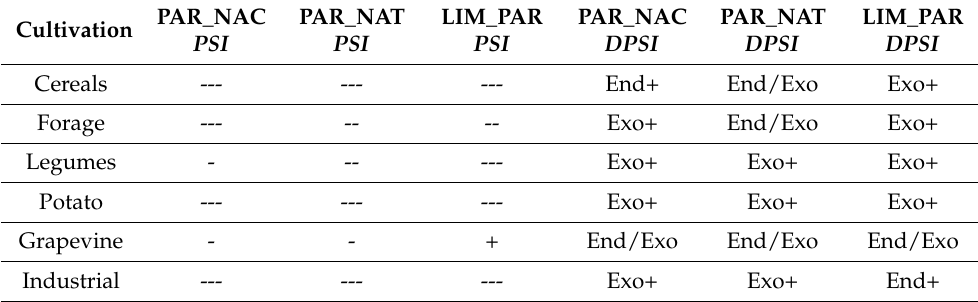
Table 3. Trends in specialization according to types of crops